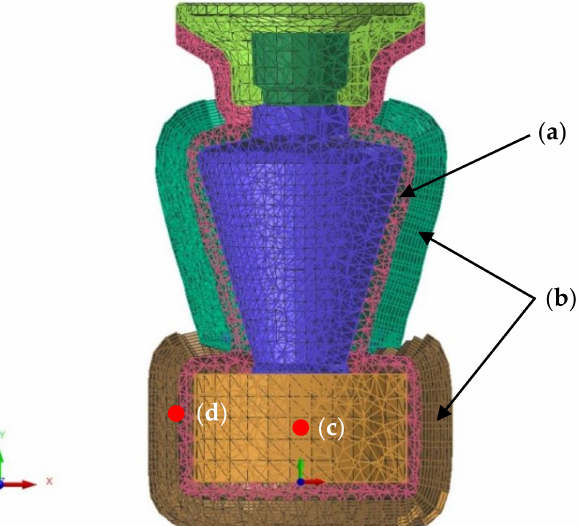
Figure 11. Positioning thermocouples in the current study (cross section view). ( a ) Ceramic shell, ( b ) wool blanket, ( c ) positioning the thermocouple on the alloy (centre part), and ( d ) positioning the thermocouple on the wool